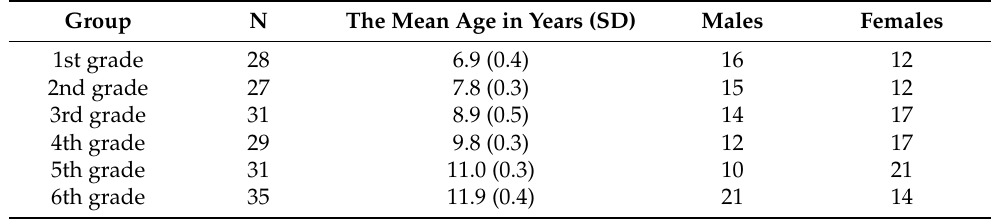
Table 1. Group, sample size, mean age, and gender distribution. Group